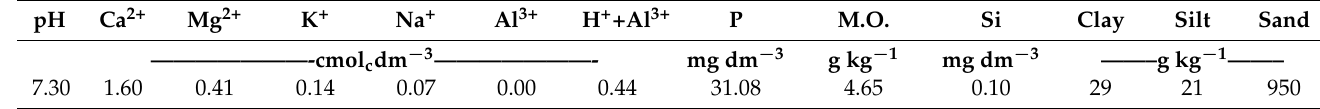
Table 1. Physicochemical soil of the experimental area in the 0–20 cm